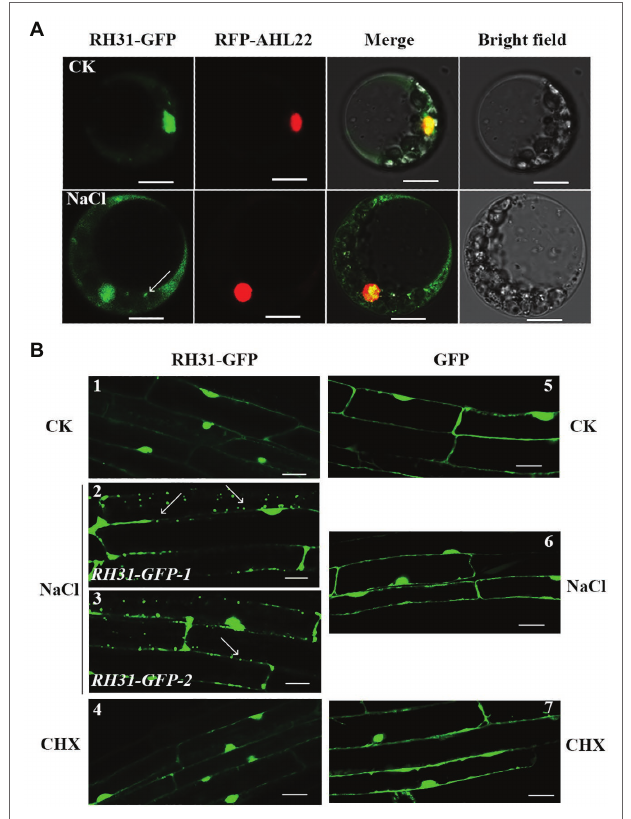
FIGURE 2 | Subcellular localization of RH31-GFP. (A) Intracellular distribution of RH31-GFP and RFP-AHL22 in living Arabidopsis protoplasts. RH31-GFP mainly distributed in cell nucleus under normal condition (top row), but rapidly shifted to the cytoplasm and redistributed to small granules after 5 min treatment with 150 mM NaCl (bottom row). Scale bars = 10 μ m. (B) Confocal micrographs of root elongation zones of 7-day-old seedlings. RH31-GFP mainly localized to cell nucleus under normal condition (1), but shifted to the cytoplasm and formed a number of small granules when seedling roots were treated with 150 mM NaCl (2 and 3). RH31-GFP seedling roots under salinity no longer showed small granules after treated with CHX (4). GFP transgenic lines under normal (5), salt stress (6), and CHX (7) conditions were used as controls. Scale bars = 20 μ m. CK, Control; CHX, Cycloheximide. (2) and (3) represent two RH31-GFP lines. Arrows point to the